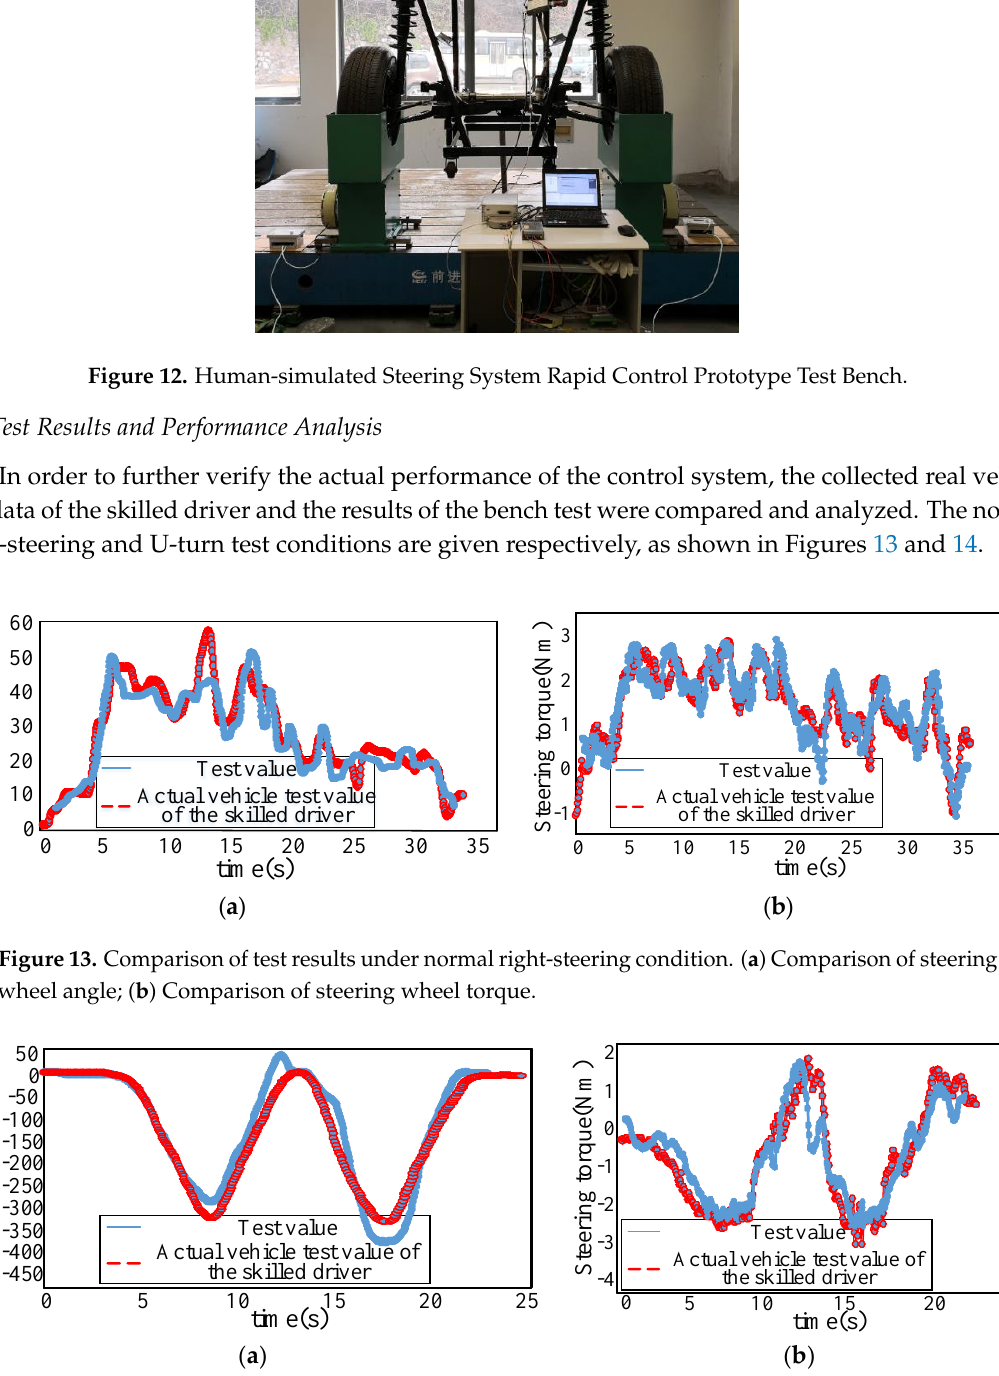
Figure 14. Comparison of test results under U-turn condition. ( a ) Comparison of steering wheel angle; ( b ) Comparison of steering wheel torque.